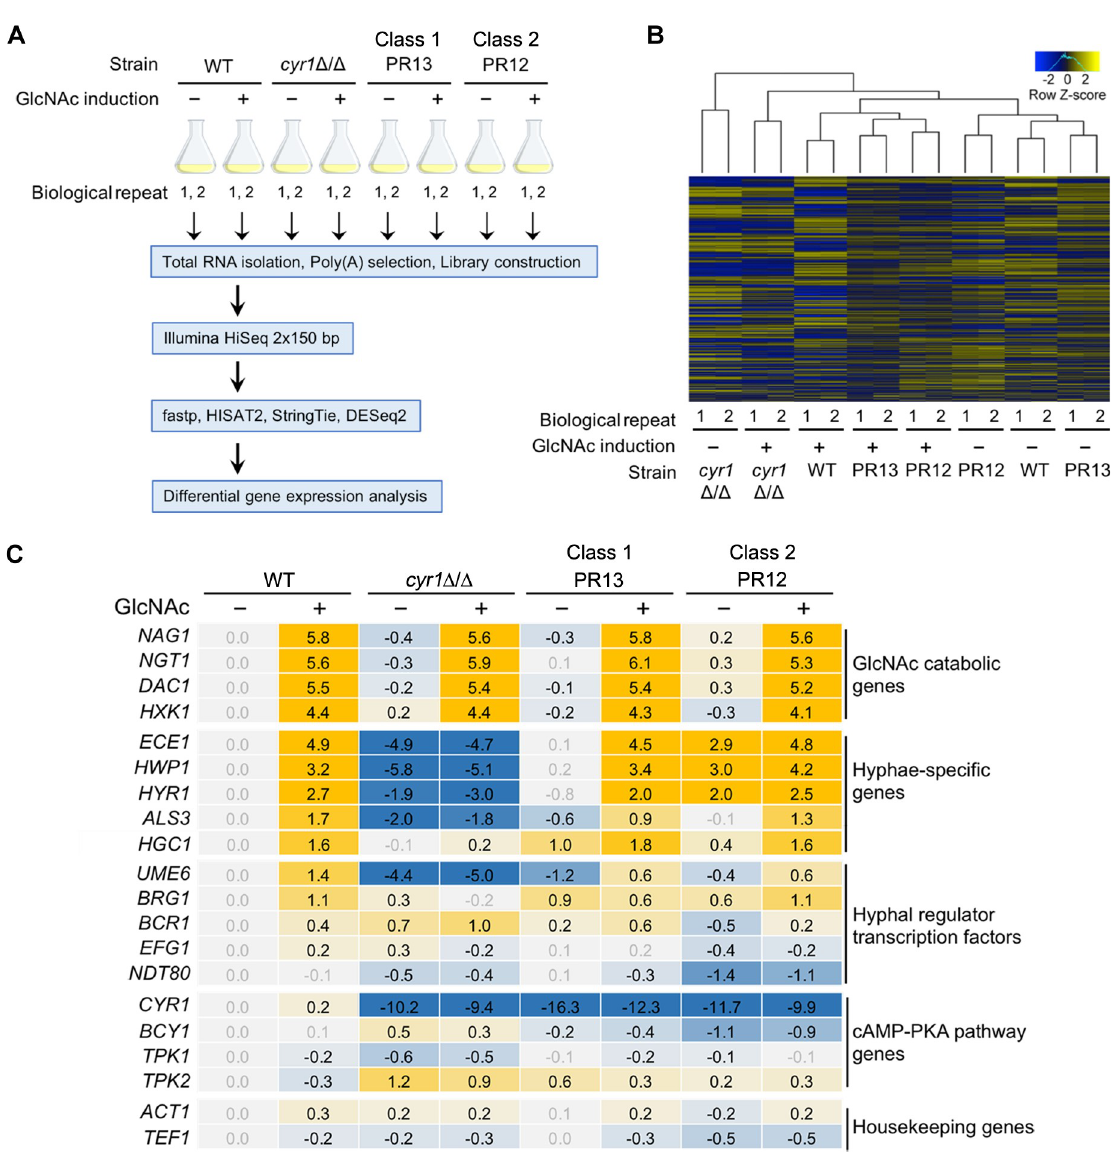
Fig 3. Adenylyl cyclase is not necessary for transcriptional regulation of hyphal-induced genes. (A) Experimental scheme of transcriptomic analysis. Cells were grown at 37˚C in liquid galactose medium and then 50 mM GlcNAc was added for 2 h to induce hyphae. There were 2 biologically independent replicates for each condition. (B) Cluster analysis of differentially expressed genes (DEGs). (C) Summary of differential expression analysis. The numbers in colored boxes are log 2 difference of transcript levels compared to the wild- type − GlcNAc condition. Grey numbers indicate the difference is not significantly different (adjusted p >